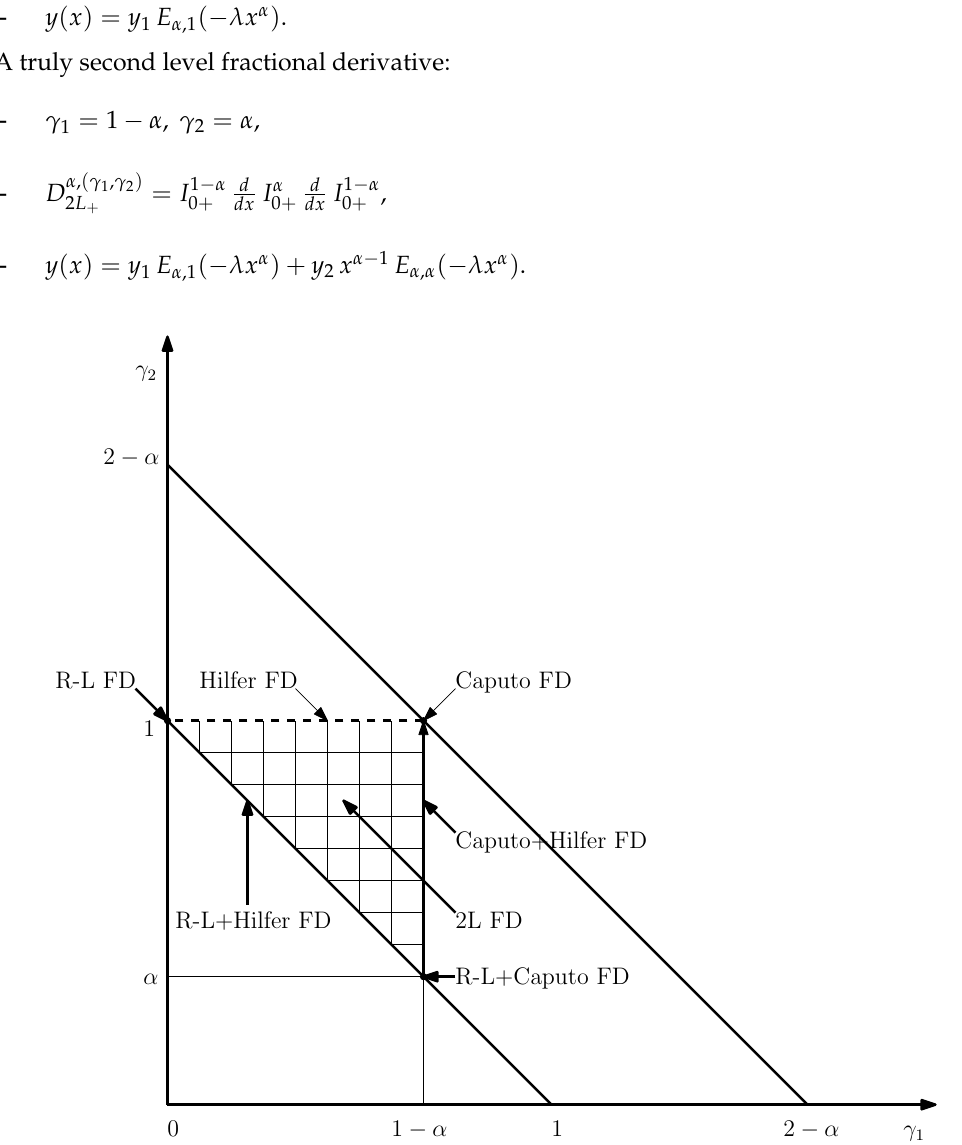
Figure 1. Second level fractional derivatives of order α ∈ [ 0,1 ] and type ( γ 1 , γ 2 )